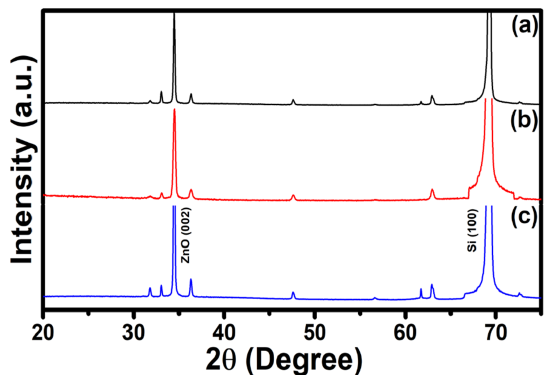
Figure 4. XRD Analysis of ZnO NRs on the surface of Si at ( a ) 3 h, ( b ) 4 h, and ( c ) 5 h treatment time.